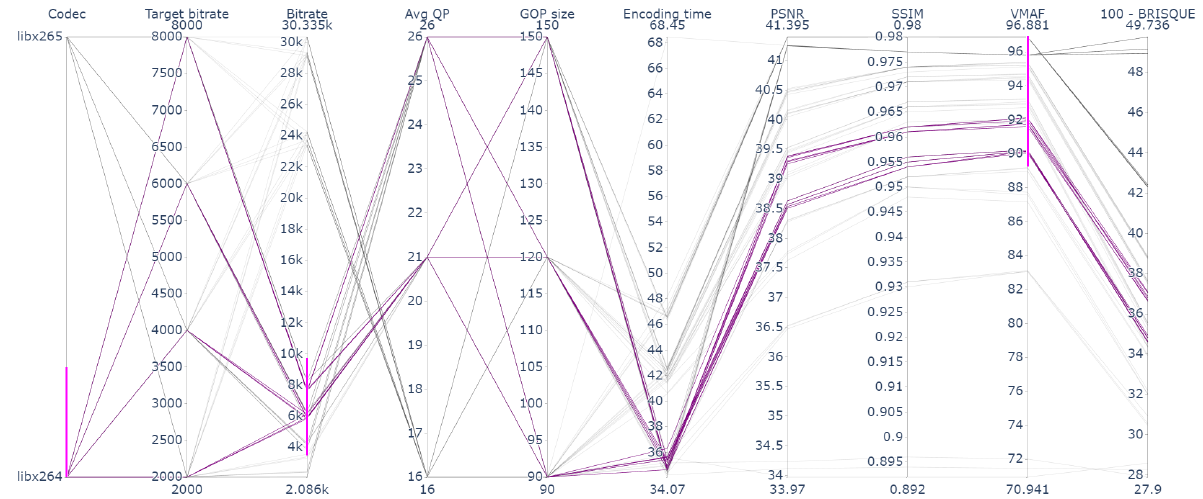
Figure 7. Video encoding results for x264 purple color and x265 teal color with various parameters, encoding times, and quality data, interpreted using parallel coordinates.